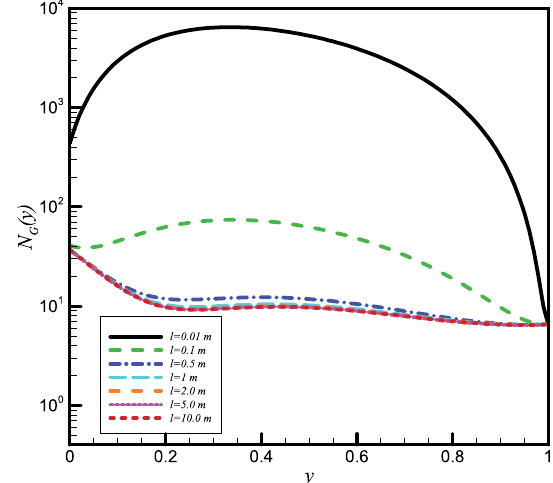
Fig. 16. Variation of entropy generation parameter, N G ( y ) , with respect to y for different values of Hartmann number.